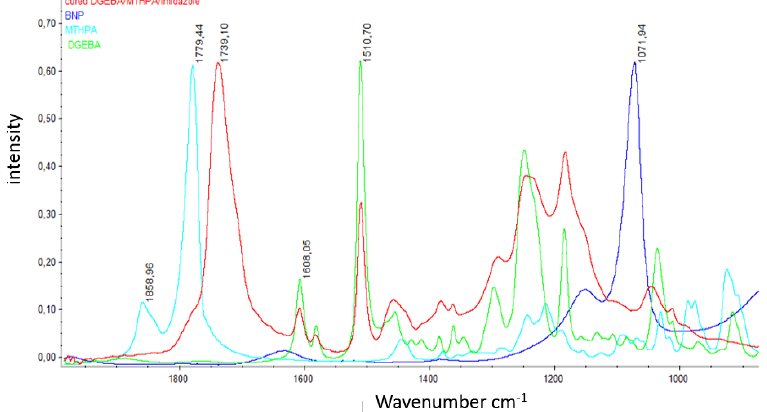
Figure A6. Room temperature ATR-IR spectra of BNPs, epoxy resin DGEBA, anhydride hardener MTHPA, and the thermally-cured DGEBA / MHTPA / imidazole(accelerator) with 100:90:1 mixing ratio and 120 curing